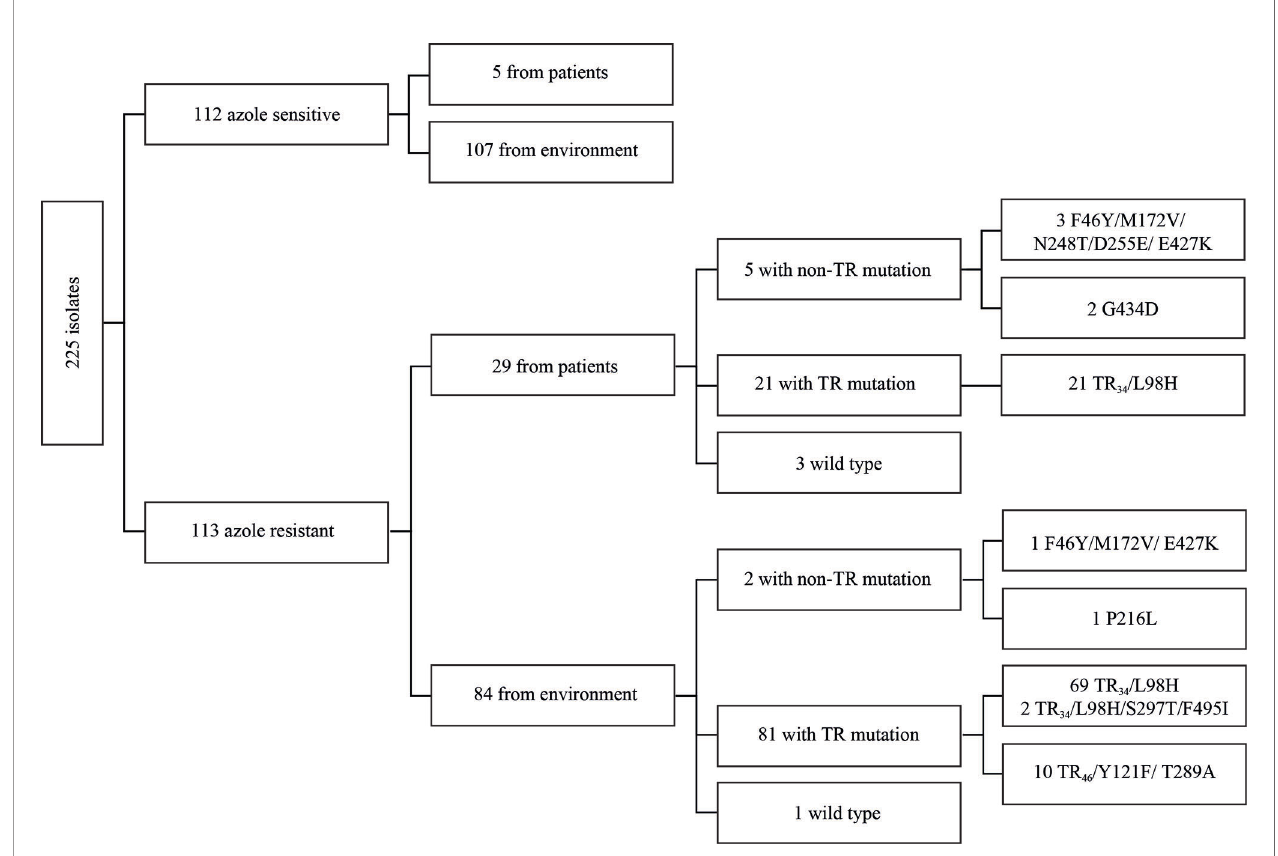
FIGURE 1 | Diagram with type of sampling, azole resistance, and cyp51A mutations of analyzed